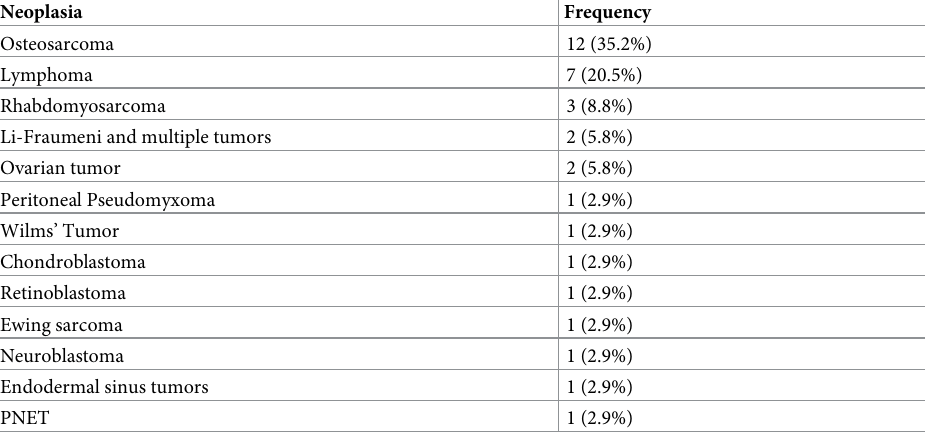
Table 1. Frequency of neoplasms in the